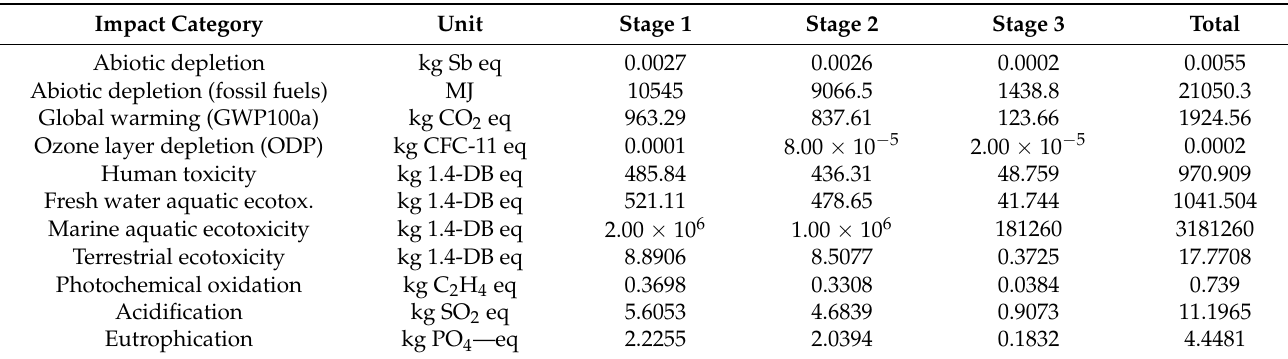
Table 19. Impacts generated by each stage of the 2-piece stopper manufacturing activity with dimensions of 26 × 44 by drilling.